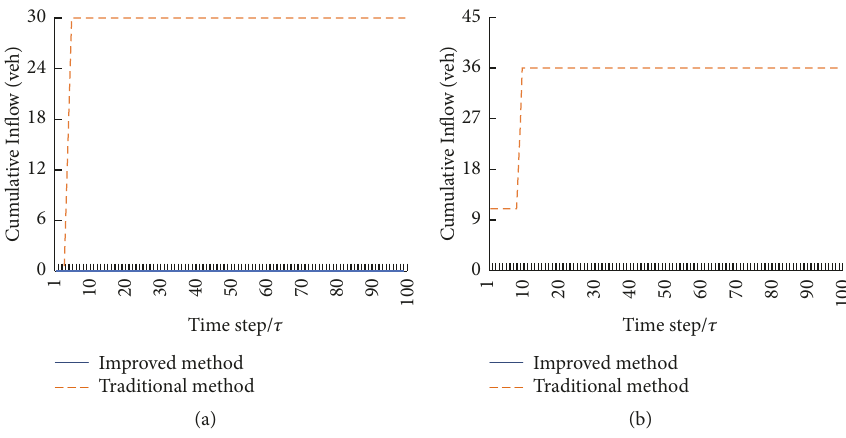
Figure 8: Cumulative vehicles driving into road (7,6): (a) low demand; (b) high